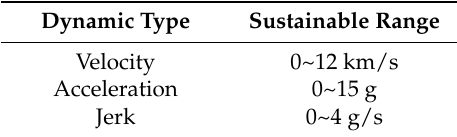
Table 3. The mission control sequence (MCS) of the lunar probe during the simulation time.